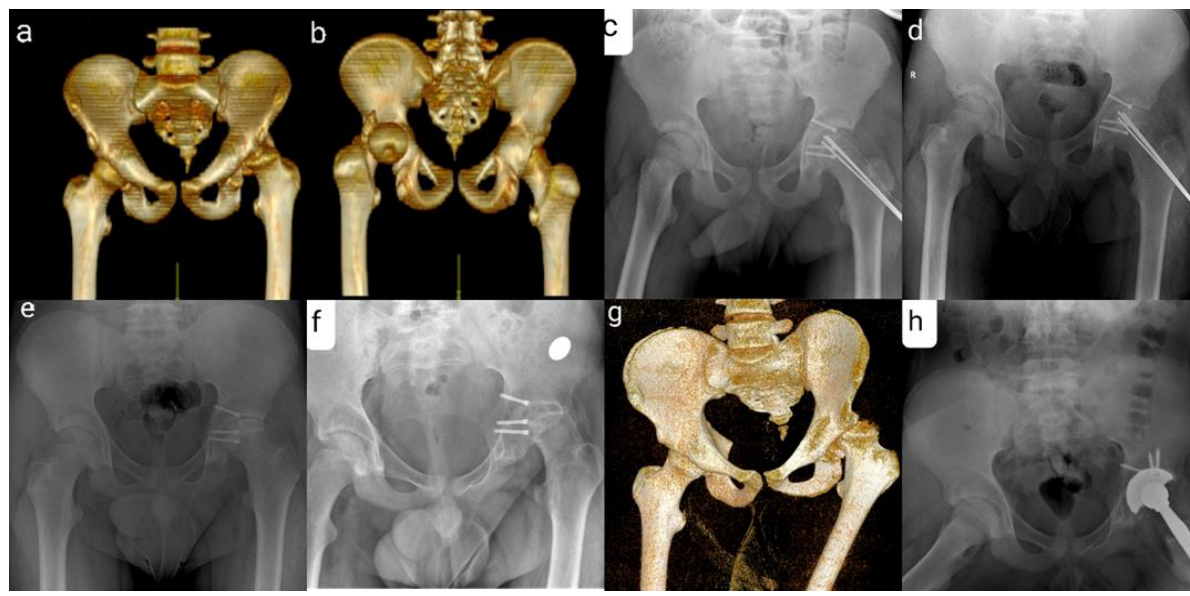
Figure 3. ( a , b ) Fracture-dislocation of the left hip associated with posterior column fracture of the acetabulum — CT image. ( c ) Postoperative X-ray. ( d ) Signs of femoral head necrosis 4 months after surgery. ( e ) X-ray of the pelvis after removal of the threaded Kirschner wires ( f ) Pelvic radiography 1 year and 8 months after surgery. ( g ) Pelvis CT 1 year and 8 months after surgery. ( h ) X-ray after total left hip arthroplasty.